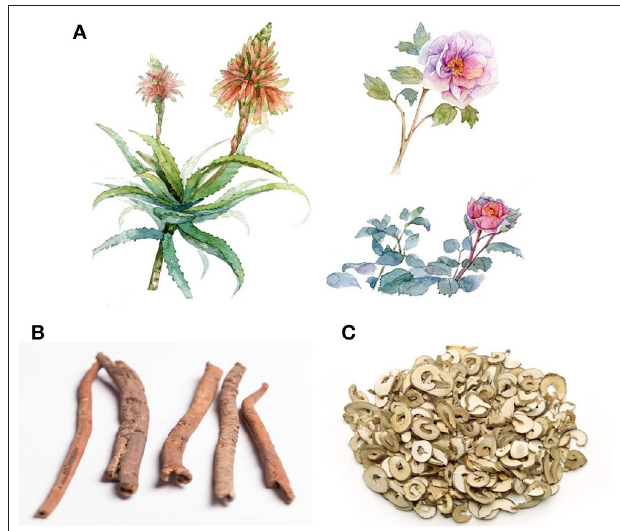
FIGURE 1 | Whole plant and root bark of Paeonia suffruticosa . (A) Paeonia suffruticosa is a kind of plant with ornamental and medicinal values. (B) Cortex Moutan, the root bark of Paeonia suffruticosa , is a natural medicine with a variety of biological effects. (C) prepared slices of Cortex Moutan, containing various bioactive pharmacological